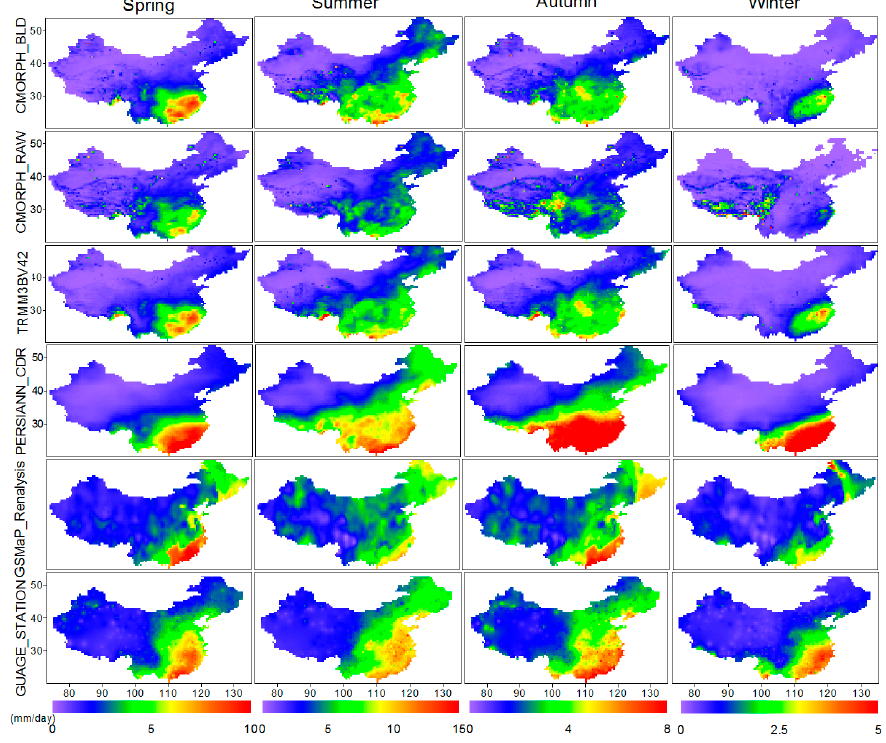
Figure 4. Seasonal nine-year daily mean rainfall features of CMOPRH_BLD, CMORPH_RAW, TRMM3BV42, PERSIANN_CDR, GSMaP_RENALYSIS and GAUGE_STATION.